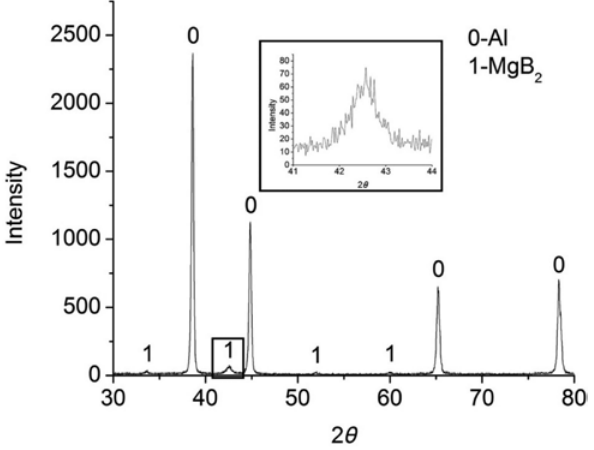
/Al nanocomposite pellet. The inset 2 peak in the square. 2